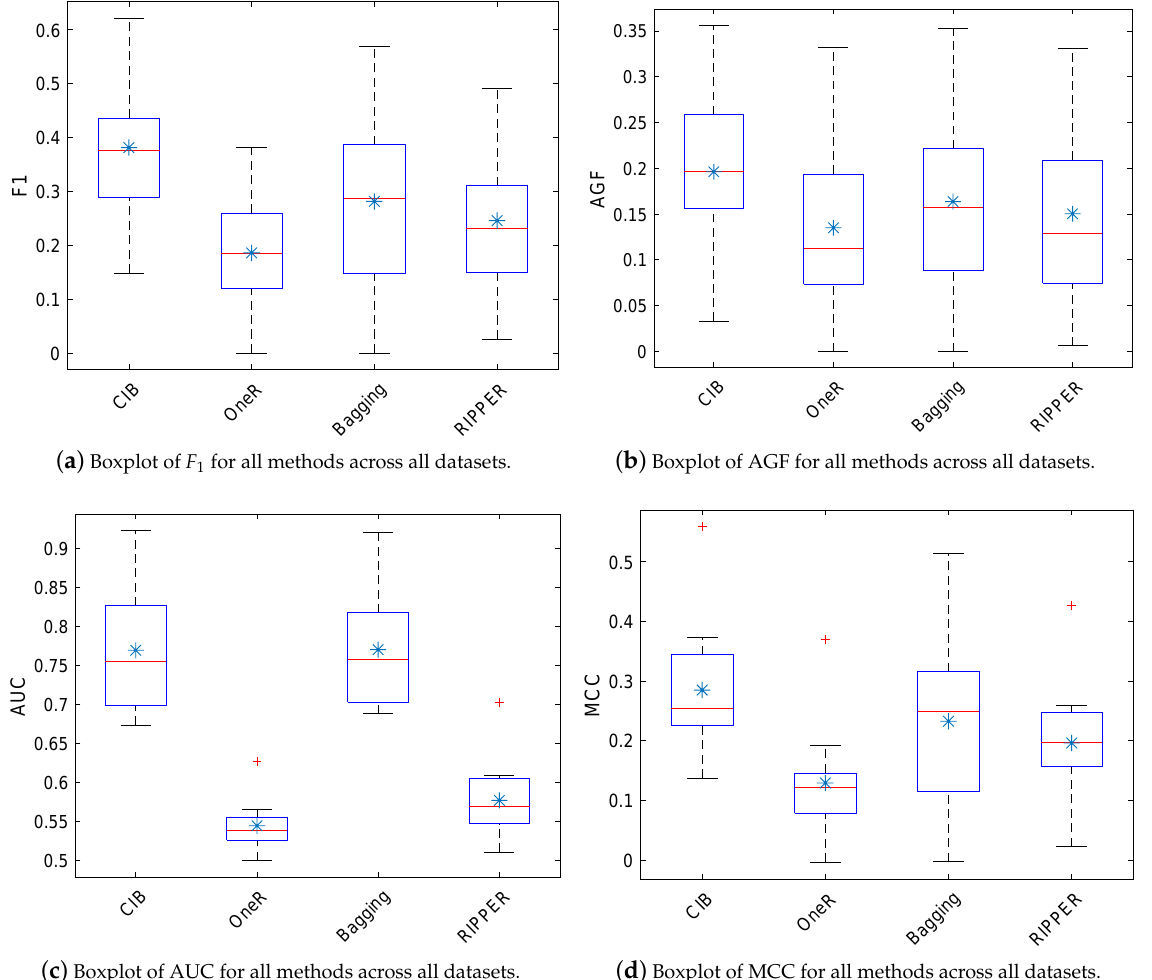
( d ) Boxplot of MCC for all methods across all datasets. Figure 5. Boxplot of F 1 , AGF, AUC, and MCC across all NASA datasets for our CIB and the baselines. The horizontal line in the box denotes the median, the asterisk indicates the mean value, and the red cross represents